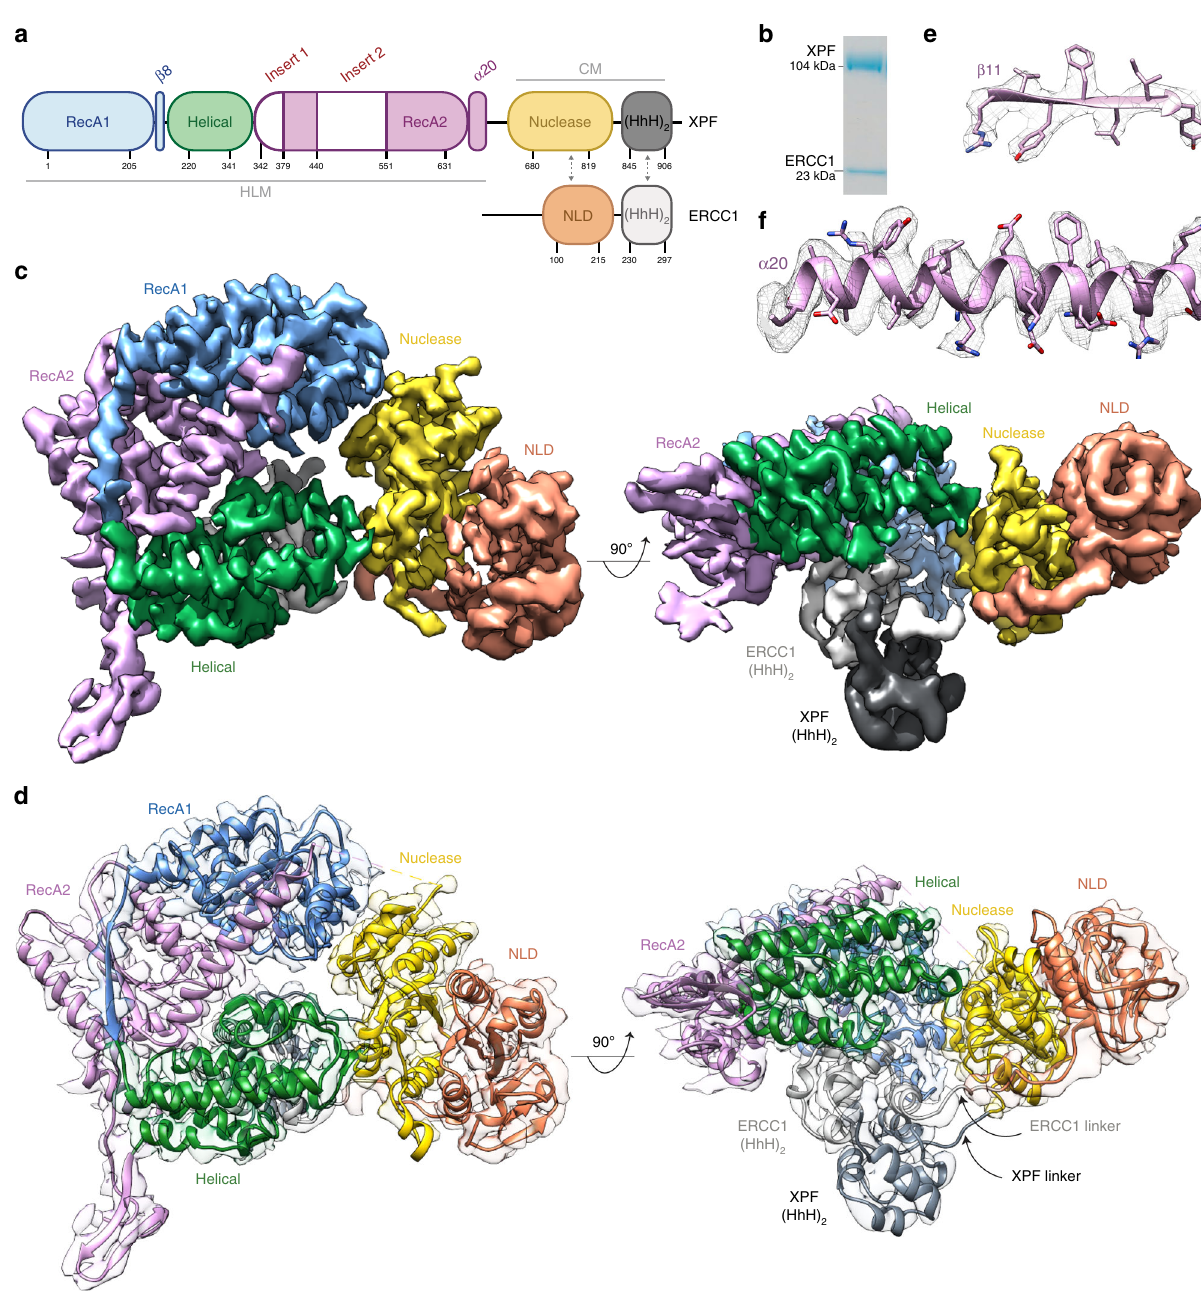
Fig. 1 Structure of auto-inhibited human XPF – ERCC1 endonuclease. a Domain architecture of XPF – ERCC1 colour coded by domain. XPF: RecA1 (blue), helical (green), RecA2 (pink), nuclease (gold) and (HhH) 2 (dark grey). ERCC1: NLD (orange) and (HhH) 2 (light grey). Residue numbering indicates domain boundaries and dotted arrows indicate dimerisation interfaces. Two insert sequences within RecA2 are shown in white embellishing the RecA domain fold. Grey lines de fi ne the helicase-like module (HLM) and catalytic module (CM). b SDS-PAGE gel of puri fi ed recombinant XPF – ERCC1 used for cryo-EM studies. c Two orthogonal views of the composite XPF – ERCC1 cryo-EM map ranging from a global resolution of 3.6 – 4 Å, coloured by domain according to panel a. d Final XPF – ERCC1 atomic model coloured by domain according to panel a, displayed within a transparent cryo-EM potential map. The XPF nuclease – (HhH) 2 and ERCC1 NLD – (HhH) 2 domain linker is visible at lower map thresholds. e Representative region of the cryo-EM map close to strand ß-11 and sidechains from the fi nal model in pink. f Representative part of the cryo-EM map close to α -helix 20 with sidechains shown from the fi nal model in